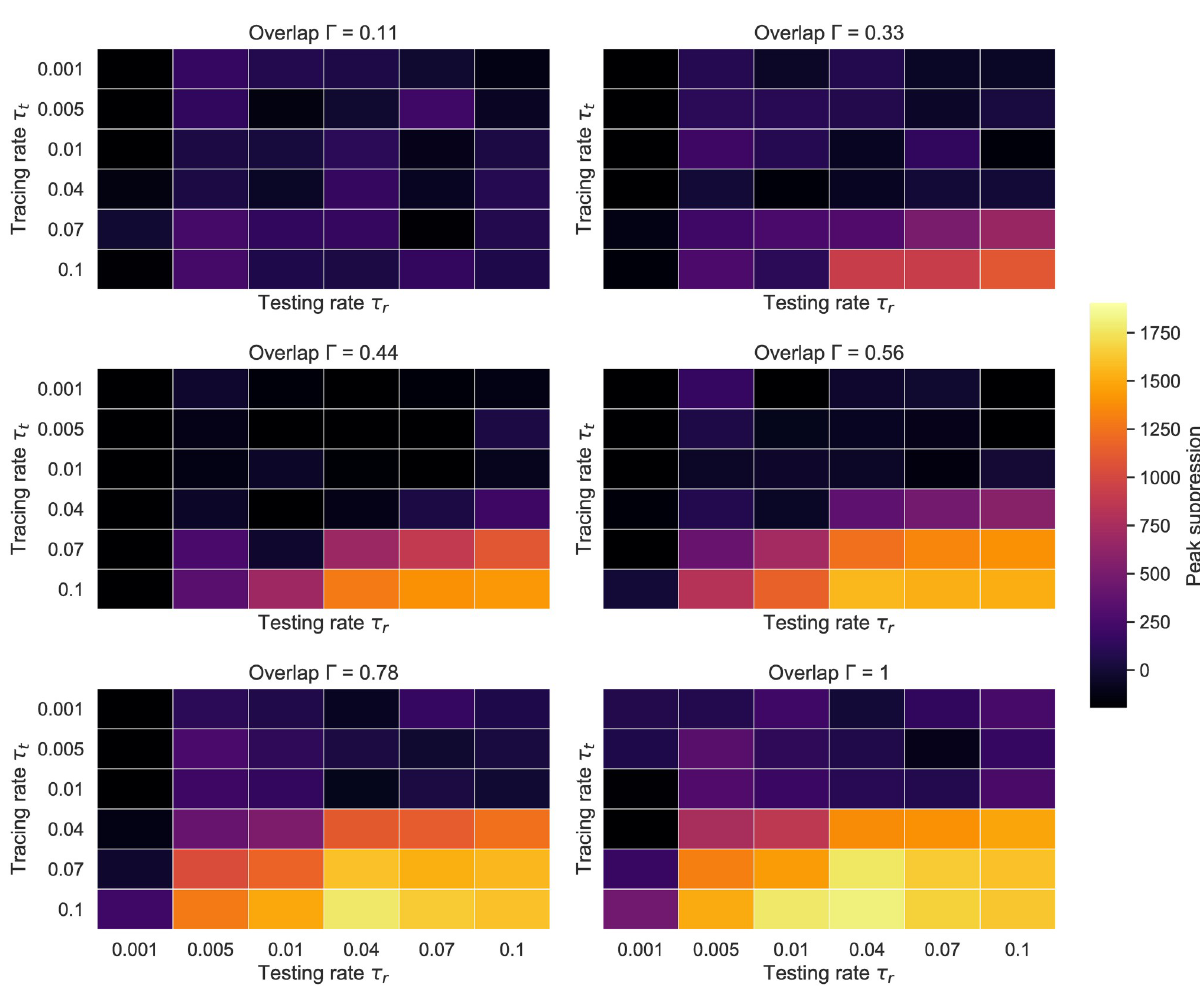
Fig 8. ER network—Heatmaps of achieved peak suppression for different testing and tracing rates. N = 10000, K = 10, p runs.